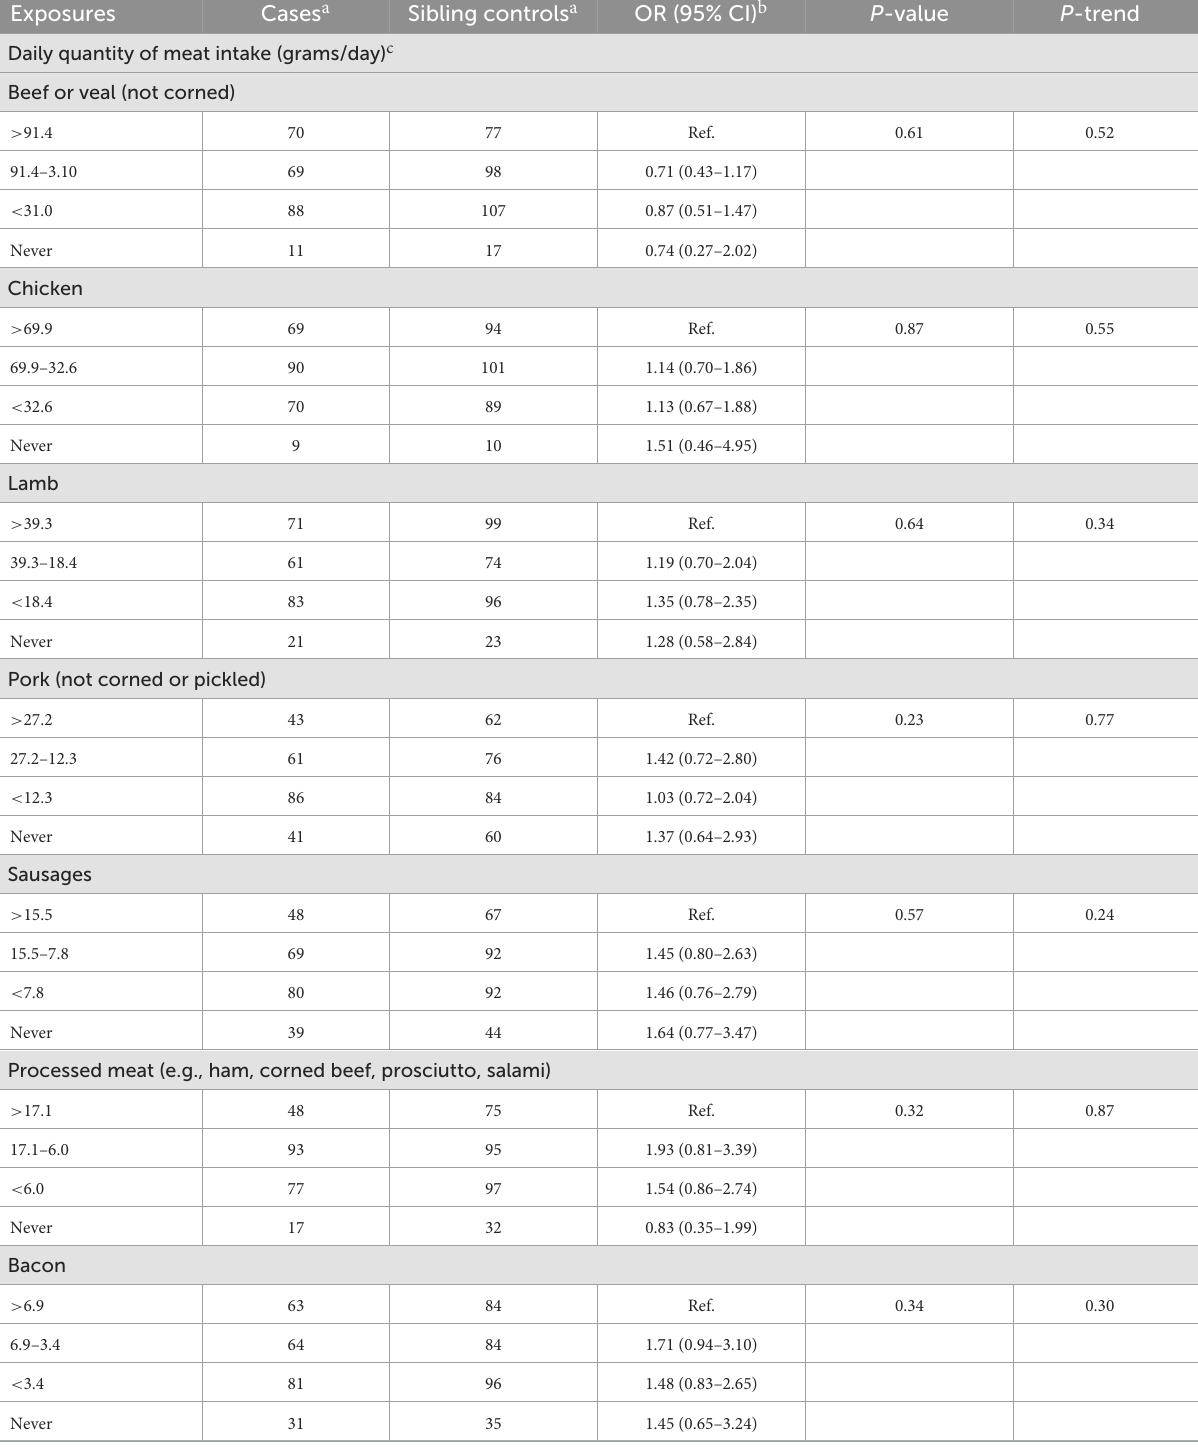
TABLE 2 Odds ratios and 95% confidence intervals for the likelihood of FL in relation to meat consumed in the year before last among cases and sibling